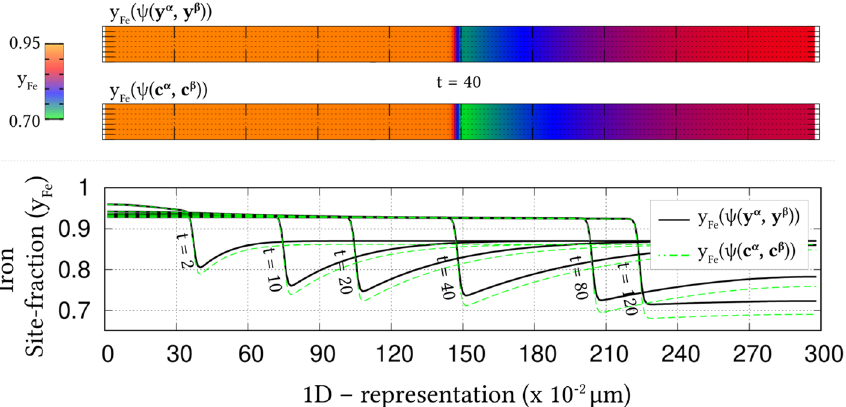
Figure 10. (Top) Difference in the concentration distribution of Fe-matrix owing to the characteristic treatment of concentrations in conventional ( ψ( c α (µ) , c β (µ)) ) and present ( ψ( y α (µ) , y β (µ)) ) grand-potential approach. (Bottom) Corresponding disparity in the evolution of one-dimensional concentration profile of matrix chemical-species due to the difference in the handling of alloying